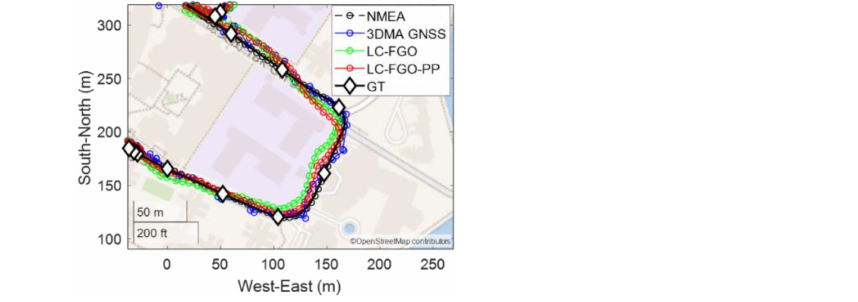
Figure 11. Zoom-in map plot of positioning error caused by badly estimated